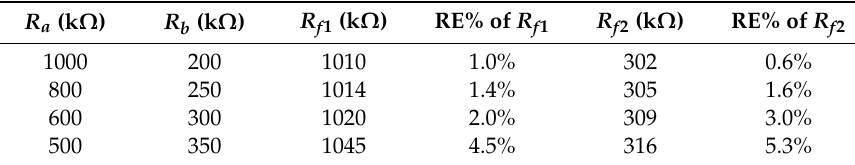
Table 2. Data results with di ff erent bridge resistors.